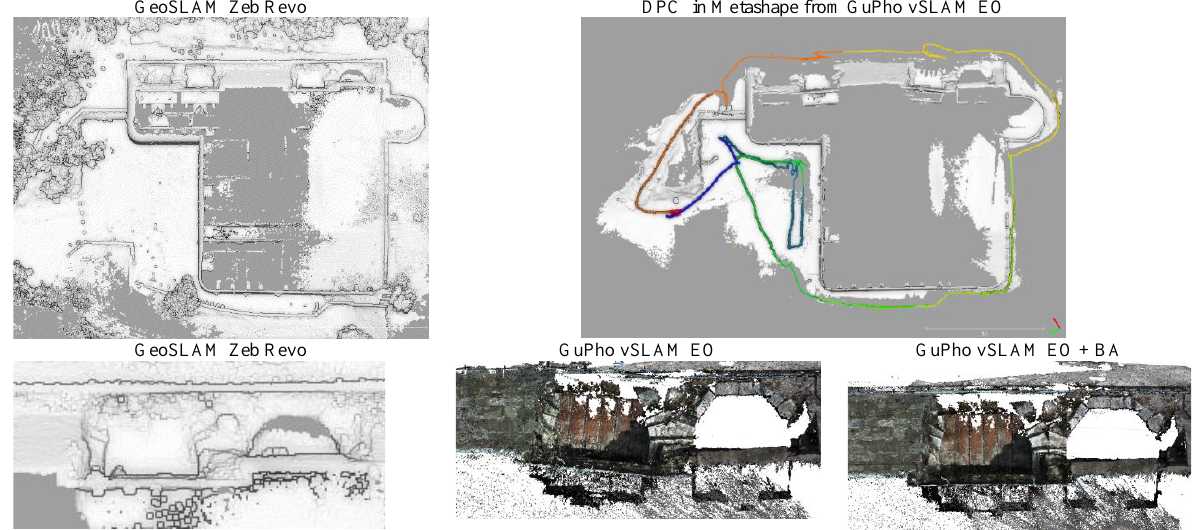
Figure 12. Top view of the two point clouds of the Batteria di Mezzo fort in Riva del Garda, Italy surveyed respectively with the GeoSLAM Zeb Revo (left), and the proposed prototype (right). See subsection 4.3 for further